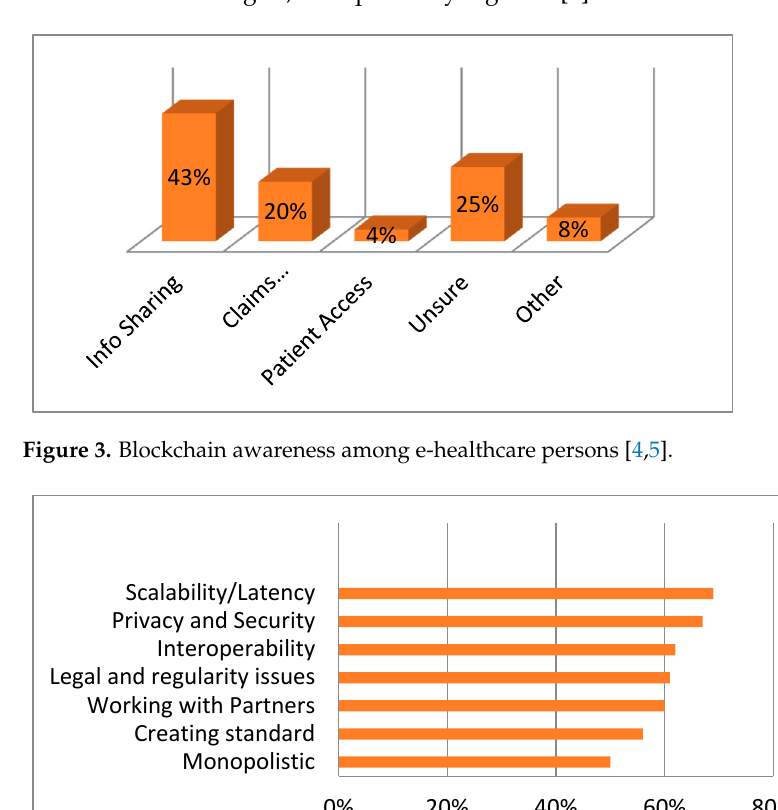
Figure 2. Investment of healthcare industries in the blockchain [2,3].